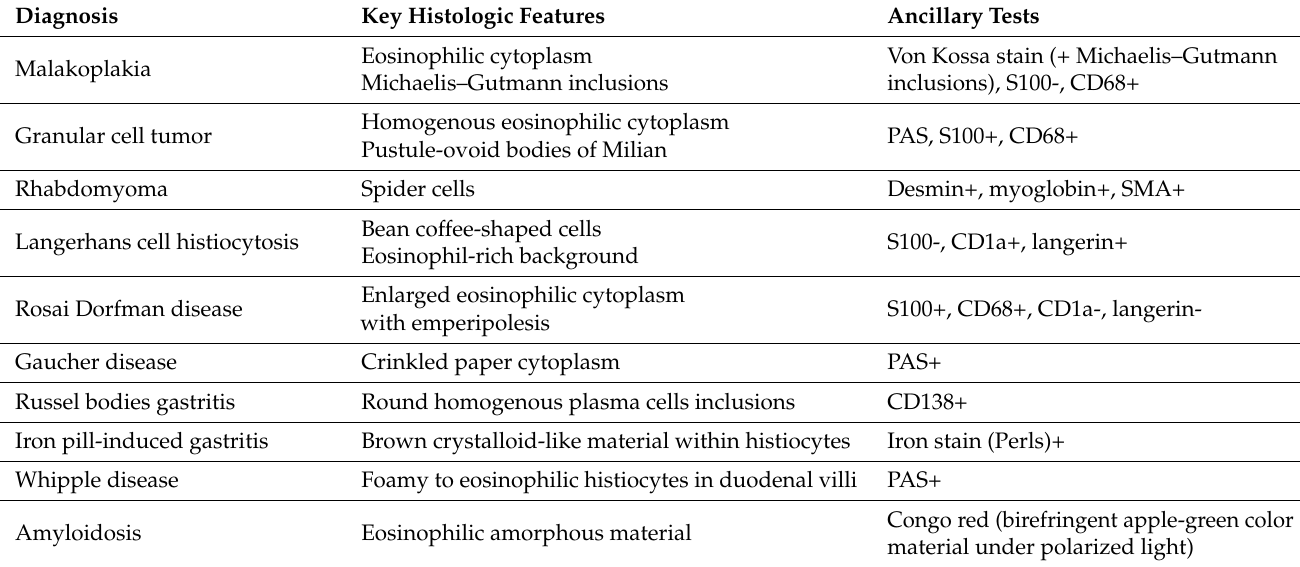
Table 3. Main differential diagnoses of crystal-storing